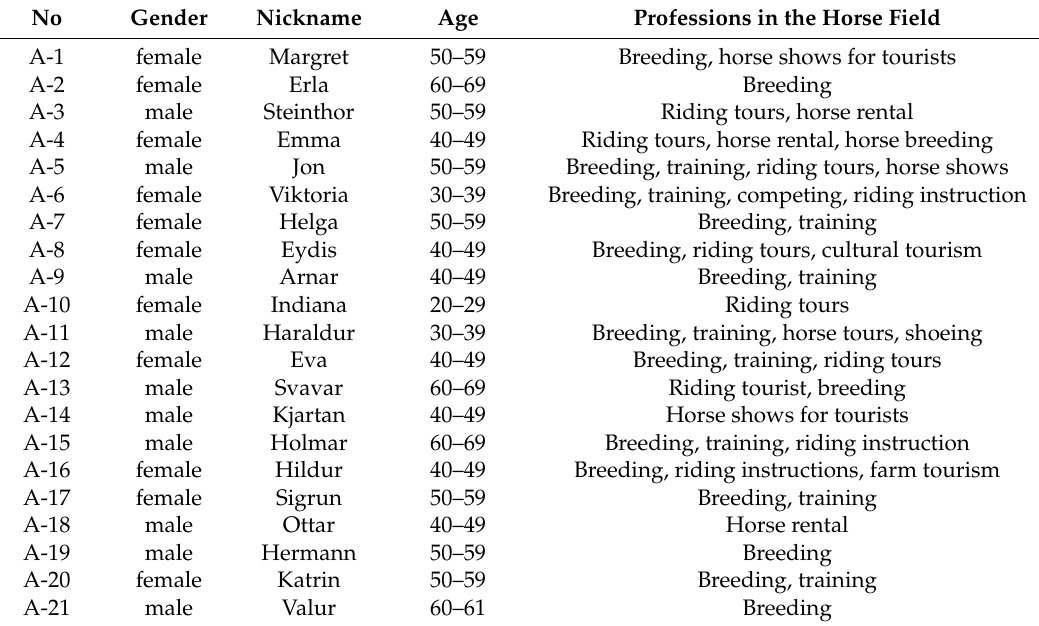
Table 1. Demographics of responding horse entrepreneurs (A).